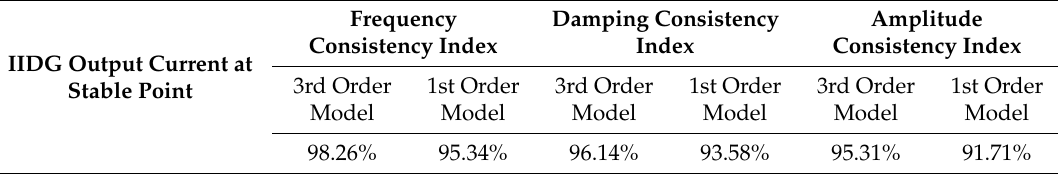
Table 5. Consistency indexes of dynamic response for reduction models in stand-alone system.